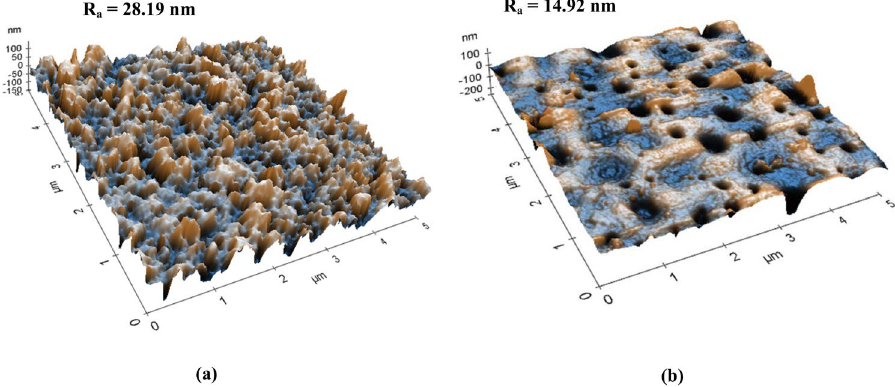
Figure 7. AFM images of ( a ) PA layer and ( b ) PMAPS layer of double-skinned membrane.